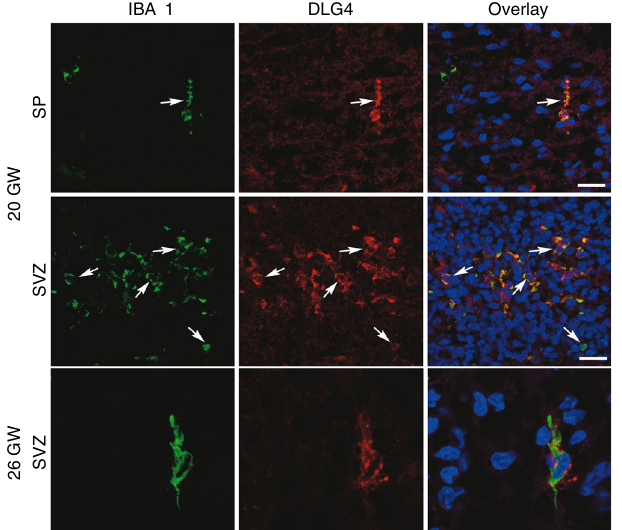
Fig. 5 Co-localisation of DLG4 protein and microglial marker IBA1 in the developing human brain. Representative photomicrographs from the subplate (SP) and subventricular zone (SVZ) through the dorsal cortex of a 20 GW ( upper two rows ) and 26 GW ( lower row ) human brain. No IBA1 PSD95 co-localisation was observed at 30GW. In green IBA1+ microglia (IBA1), in red DLG4 (PSD95) protein and fi nal column shows co-localisation of IBA1 and DLG4, together with DAPI nuclear staining. Arrows in top rows point to area of distinct co-localisation at ×20 and a higher magni fi cation is shown of a single double-stained cell in the lower panel . Scale bar two top rows = 40 µ m and lower row = 10 µ m